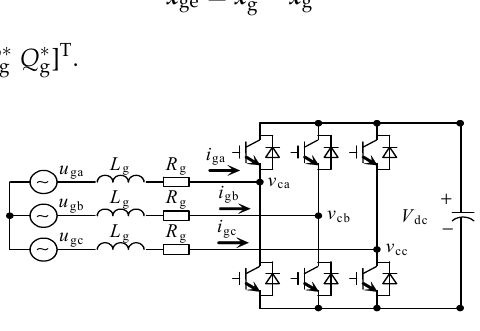
Figure 3. Circuit scheme of grid connect converter.